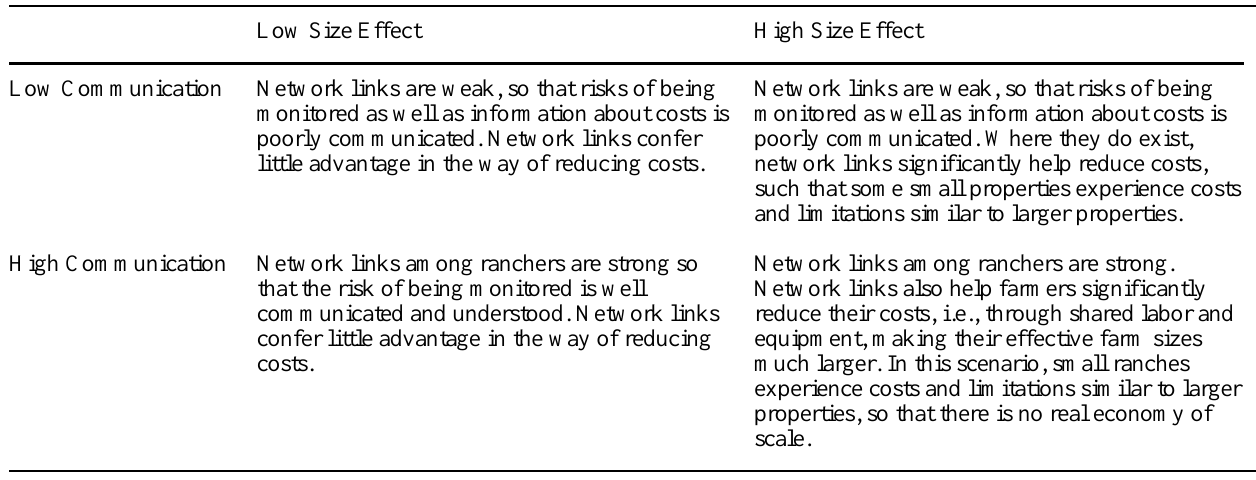
Table 2. Values for independent variables q and pbase in rancher network